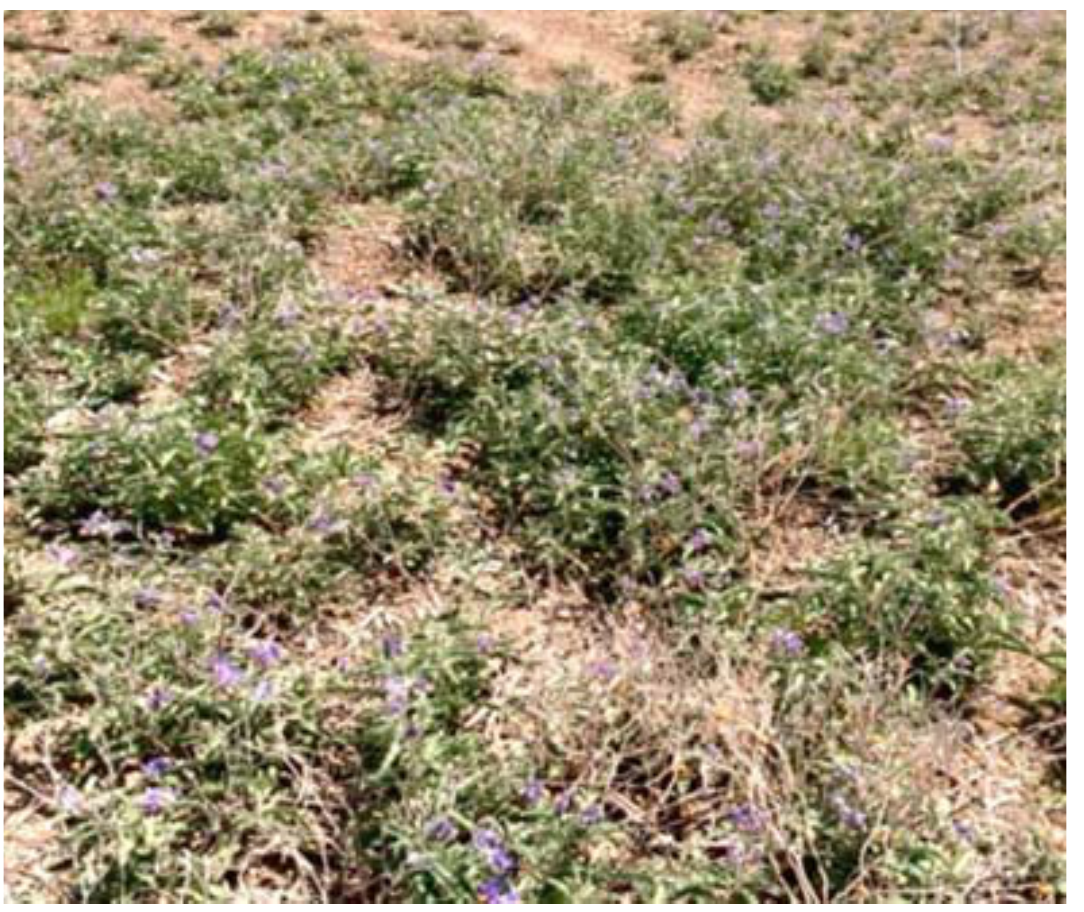
Figure 7. Solanum elaeagnifolium successful establishment in the experimental site (Chott Mariem, Tunisia, 2015).